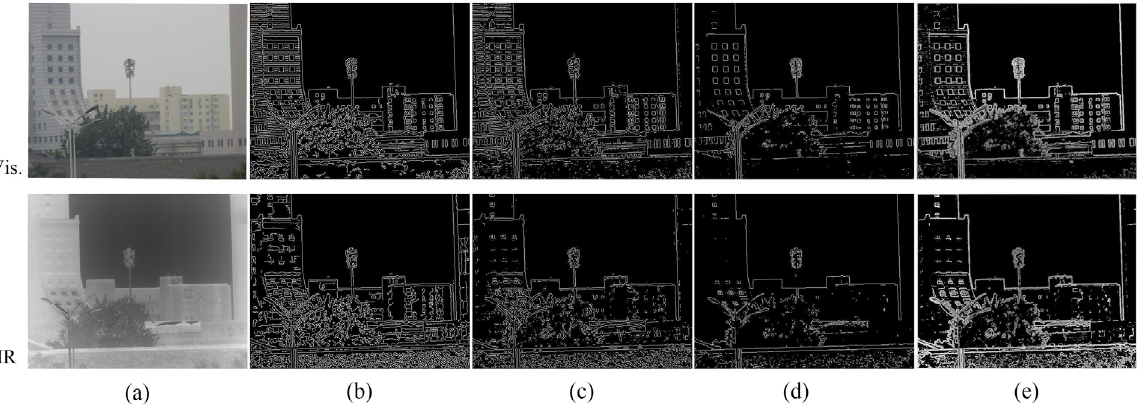
Figure 6. Infrared and visible edge images: ( a ) original; ( b ) canny; ( c ) LoG; ( d ) Sobel; and ( e ) pro- posed.